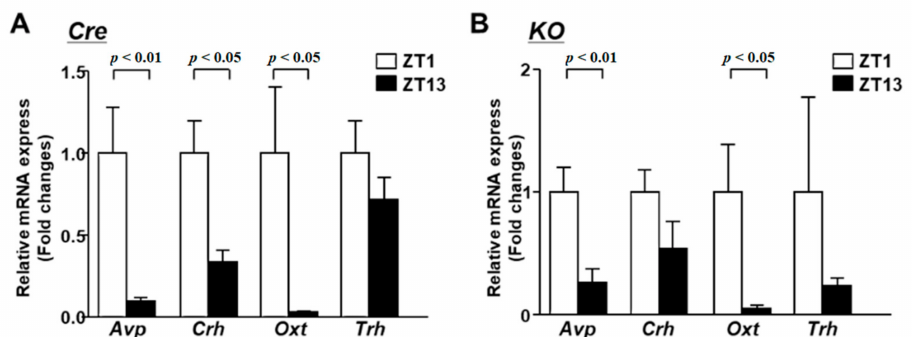
Figure 4. The mRNA expression in the PVN at light phase and dark phase. ( A ) The PVN of Cre mice at 12 weeks of age was isolated at 2 time points (ZT1 and ZT13) for mRNA isolation ( n = 6 for each group). The mRNA levels of Avp, Crh, Oxt and Trh were measured by RT-PCR and expressed as values relative to the time point of ZT0, which is arbitrarily defined as 1. ( B ) Relative mRNA expression in the PVN at ZT1 and ZT13 of KO mice at 12 weeks of age ( n = 6 for each group). Data are presented as mean ± SEM. ZT0 vs. ZT12 determined by one-way ANOVA with the Bonferroni multiple comparisons test.